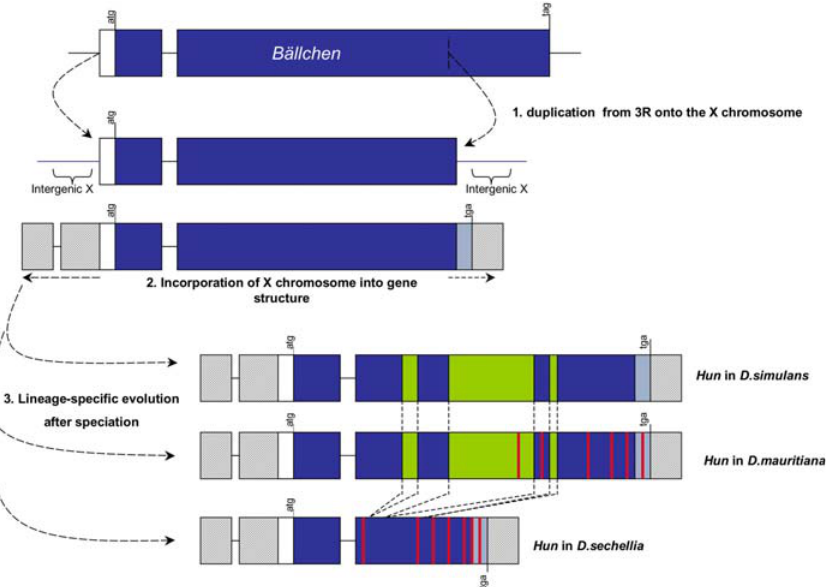
Figure 5. A Model for the Origin and Evolution of Hun Striped boxes indicate newly acquired UTR regions, white boxes indicate the Ba¨llchen 5 9 region included in duplication, grey boxes indicate newly acquired protein-coding regions, green boxes indicate regions deleted from the D. sechellia copy, and red bars represent premature stop codons. DOI: